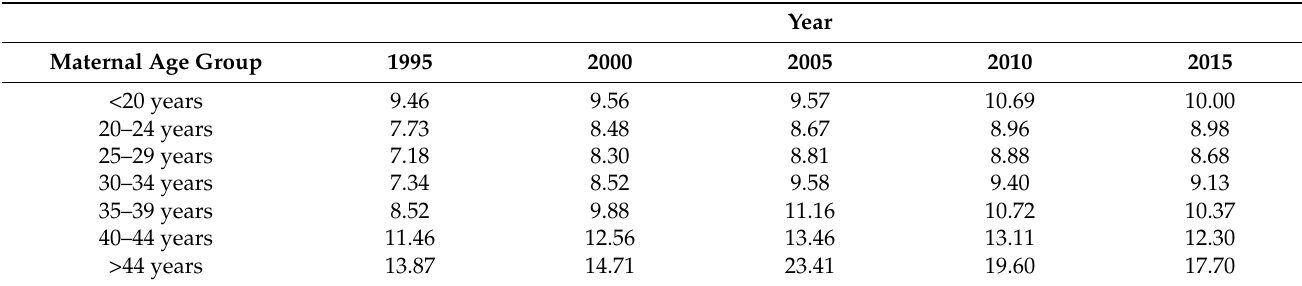
Table 3. Low birth weight rates by maternal age group for each year in all of Japan.